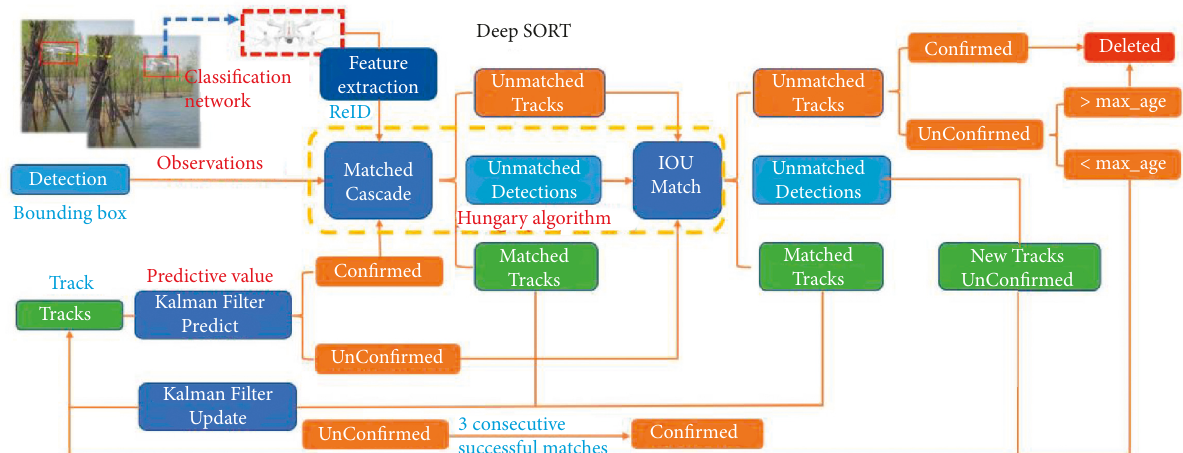
Figure 6: Workflow of the DeepSORT algorithm.